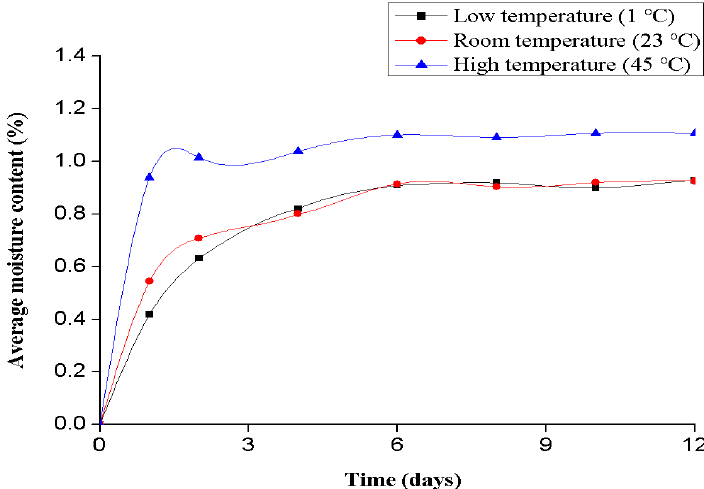
Figure 8. Variation curve of the average moisture content of red-bed sandstone at different temperatures.